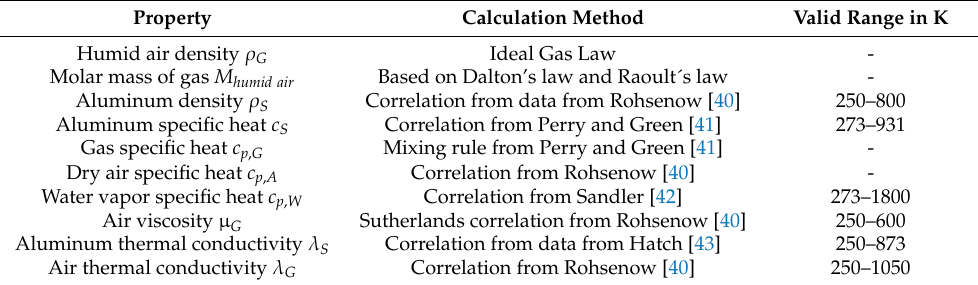
Table 1. Calculation method of thermodynamic